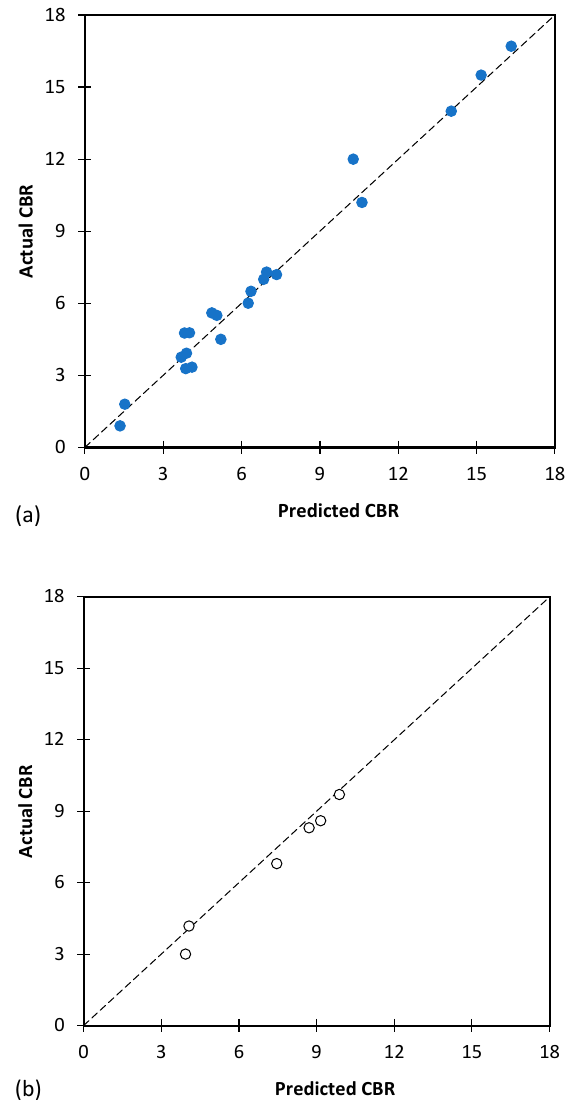
Figure 10. The results of the best GP model predicting CBR values for the ( a ) training and ( b ) testing databases.